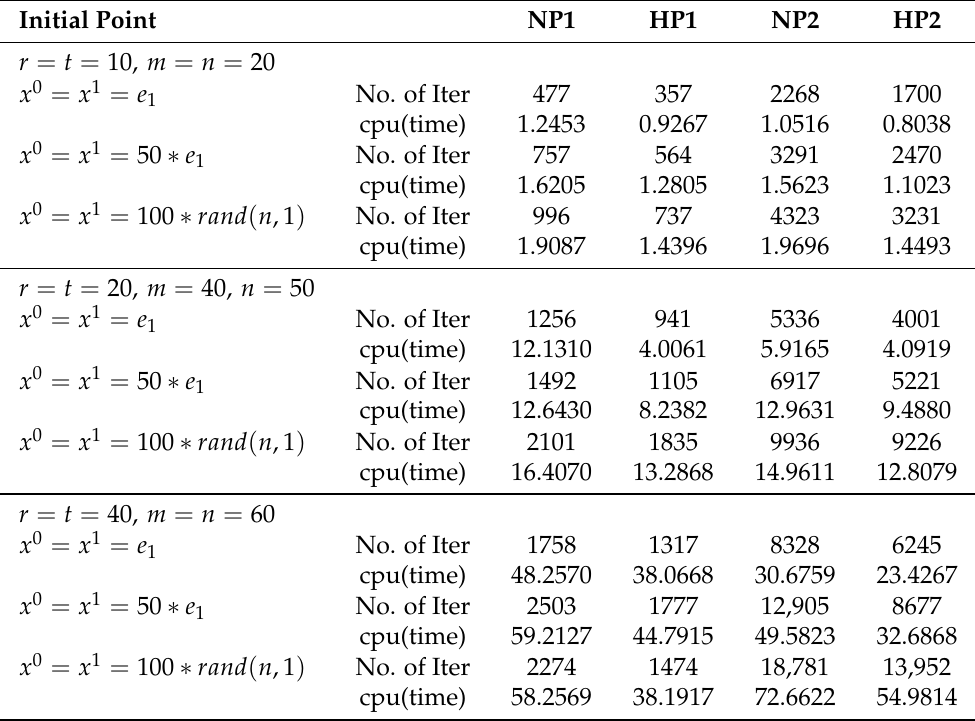
Table 4. Results of Armijo-line search and self-adaptive algorithms for Example